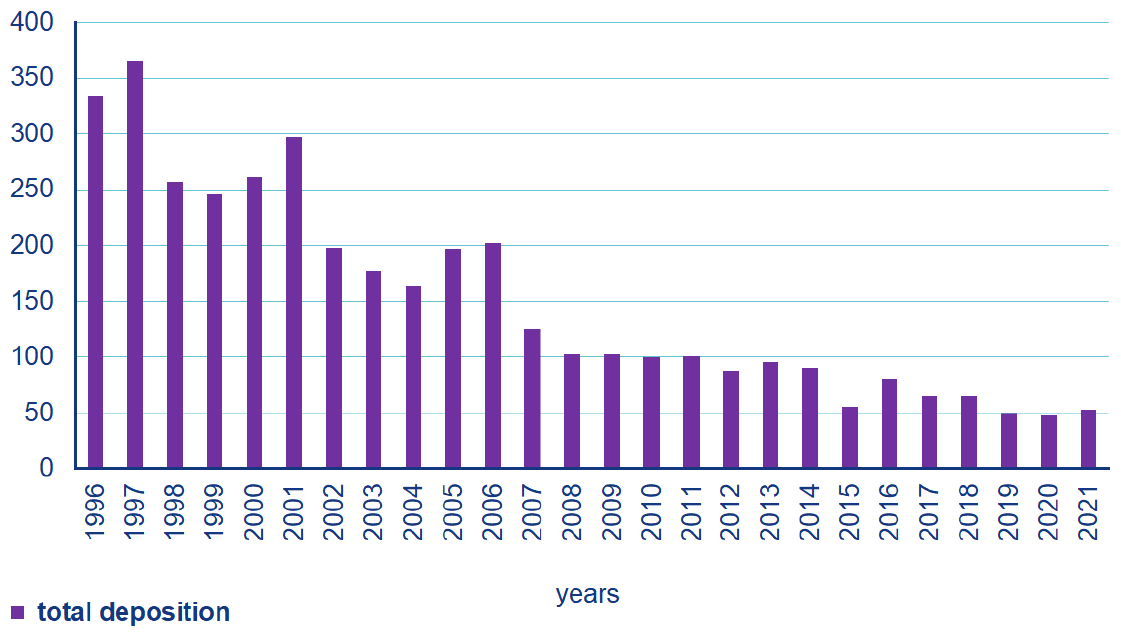
Figure 4. Relative contributions of wet and dry deposition of Pb over the entire area of the Czech Republic (78,841 km 2 ) based on data-driven geostatistic model, 1996–2021. To visualize the spatial distribution of HM annual deposition fluxes, we chose two years, 2012 and 2019, as we intended to contrast different meteorology of the respective years. Whereas 2012 can be still considered as the year representing normal conditions, 2019 represents a long-lasting hot and drought spell beginning in 2014. The total Pb deposition decreased from 88 t (over the entire CR area) in 2012 to 49 t in 2019 (Figure 3); the proportions of wet and dry deposition were nearly identical—64% and 63% of wet deposition in 2012 and 2019, respectively (Figure 4).The spatial pattern of the total annual Pb deposition (Figure 5) revealed that the most affected regions in the past (2012) were Northern Moravia and the extended region of the Jizerske hory Mts. in North Bohemia, both being adjacent to industrialized Polish regions. Later, the Pb deposition fluxes decreased over major portions of the CR. The most affected region in Northern Moravia shrunk substantially (Figure 6).